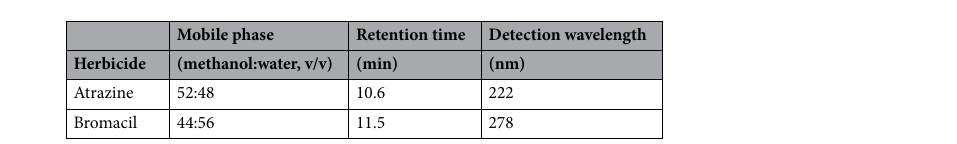
Table 4. Parameters for individual herbicides quantified by